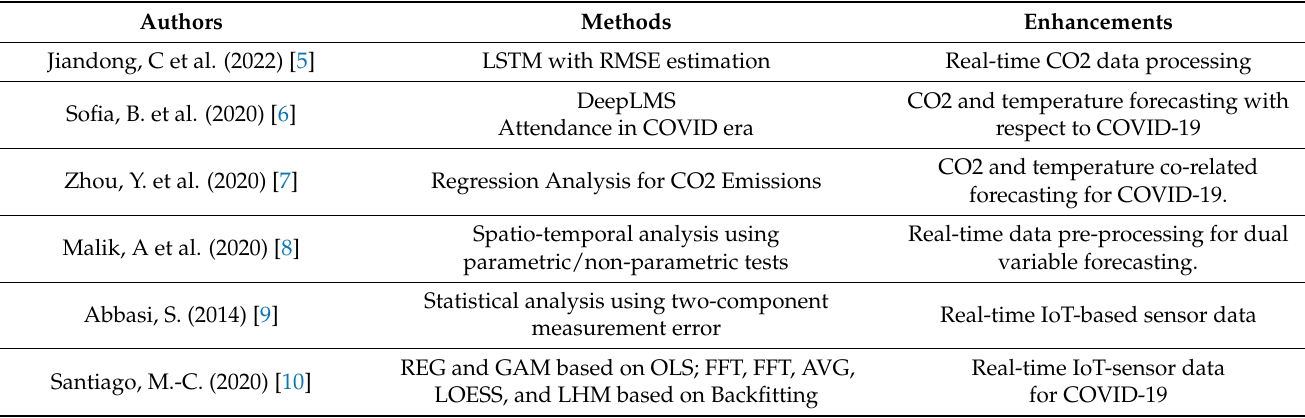
Table 1. A Summary of the Enhancements in Methods from the Literature